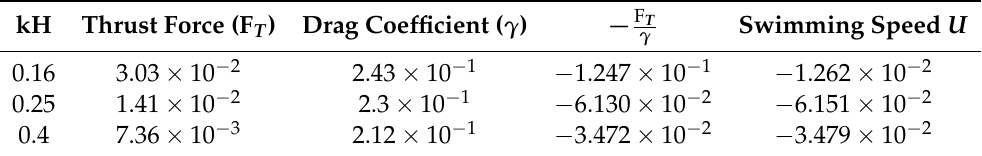
Table 1. Non-deformable interface ( β = 0.5): thrust force, drag coefficient, their ratio, and the simulated swimming speed.